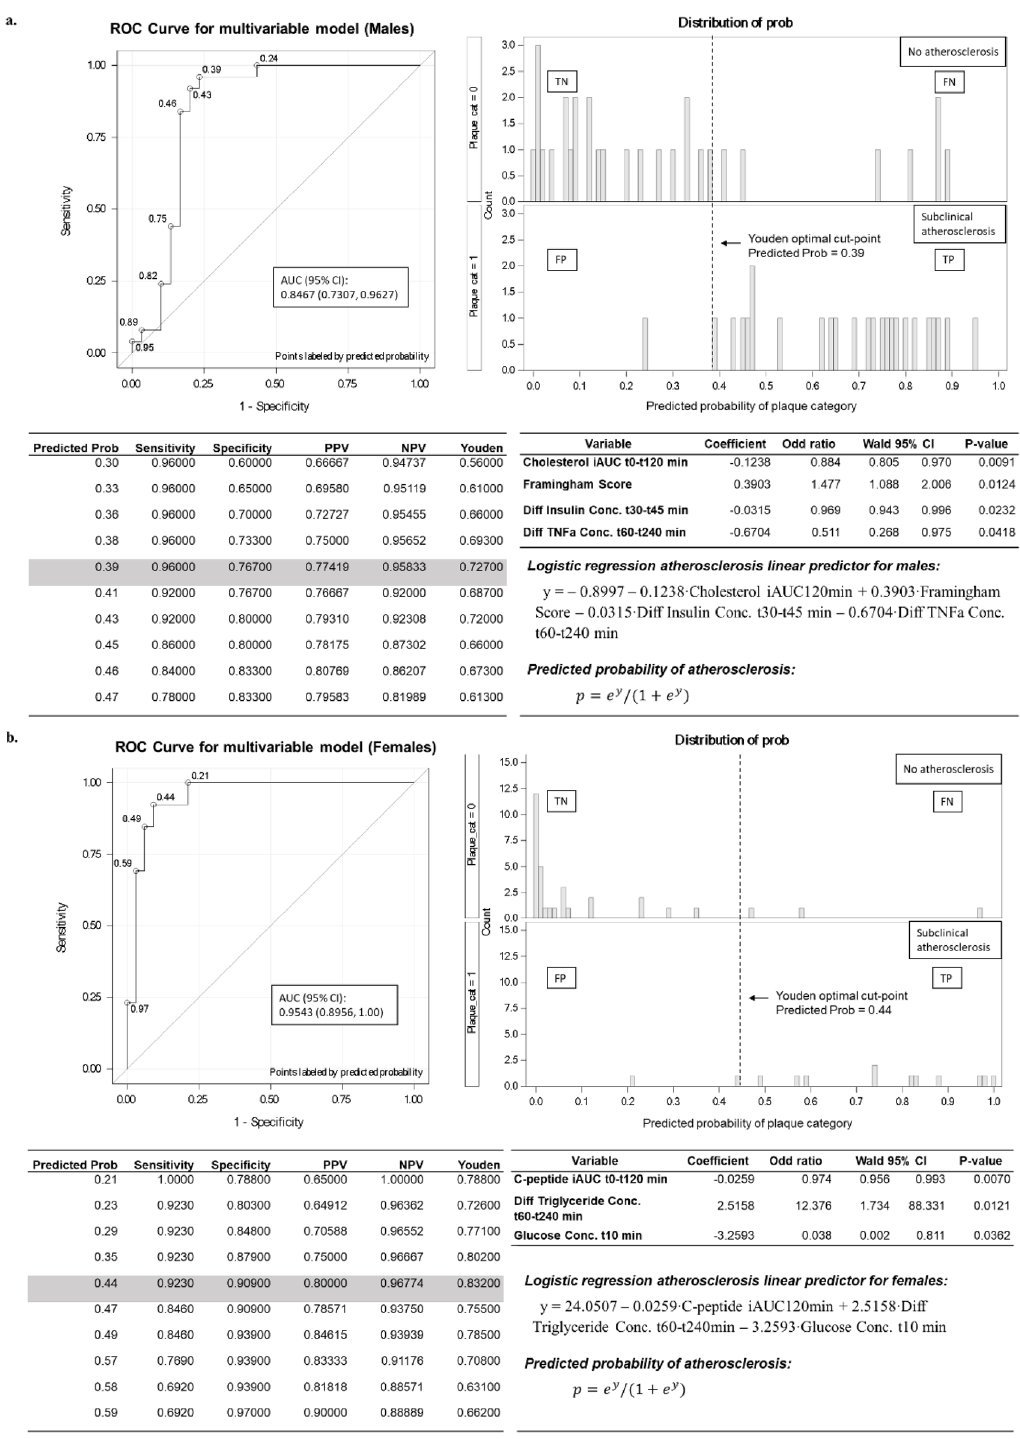
Figure 3. Summary of Logistic Regression and gender stratified ROC analysis results—A clinical tool for predicting risk of subclinical atherosclerosis in males ( a ) and females ( b ). ROC curve cut points with classification parameters, model coefficients, odds ratios and p values are shown. The ROC curve reflects prediction accuracy of multivariable model for presence of subclinical atherosclerosis. ( a ) Logistic regression atherosclerosis linear predictor for males: y = − 0.8997 − 0.1238∙Cholesterol iAUC120min + 0.3903∙Framingham Score − 0.0315∙Diff Insulin Conc. t30–t45 min − 0.6704∙Diff TNFa Conc. t60–t240 min ( b ) Logistic regression atherosclerosis linear predictor for females: y = 24.0507 − 0.0259∙C-peptide iAUC120min + 2.5158∙Diff Triglyceride Conc. t60-t240min – 3.2593∙Glucose Conc. t10 min. Predicted probability of atherosclerosis: 〖 p = e 〗 ^y/(1 + e^y). TN, True negative; FN, False negative; FP, False positive; TP, True positive; PPV, Positive predictive value; NPV, Negative predictive value; CI, Confidence interval; AUC, Area under curve; TNFa, Tumor necrosis factor alpha; iAUC, incremental area under curve; PAI-1, Plasminogen activator